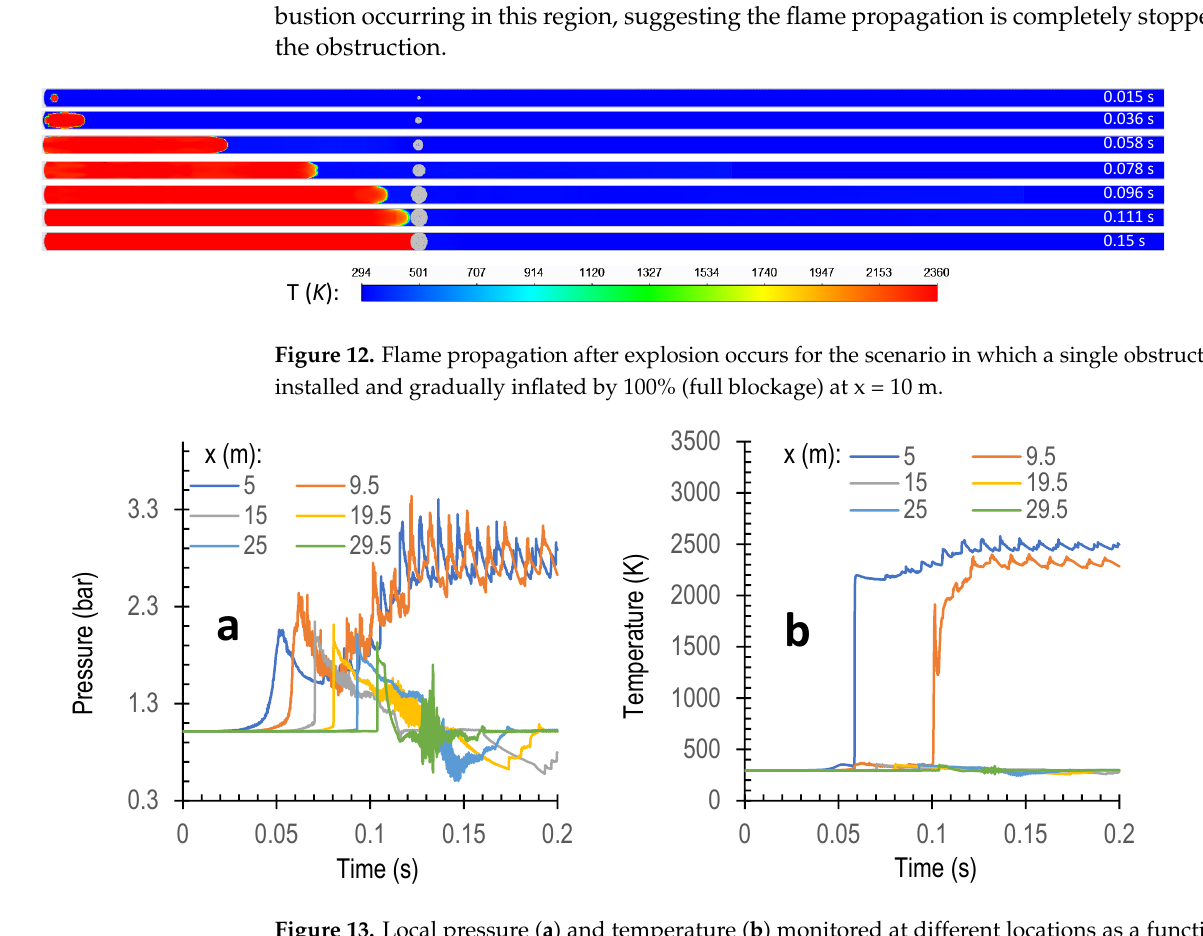
Figure 11. Evolution of pressure profiles along the tube centreline for different scenarios where a single obstruction is installed at different locations (at 10 m, 20 m and 30 m) with 50% inflation. The temperature profiles in the empty tube are also included for reference.